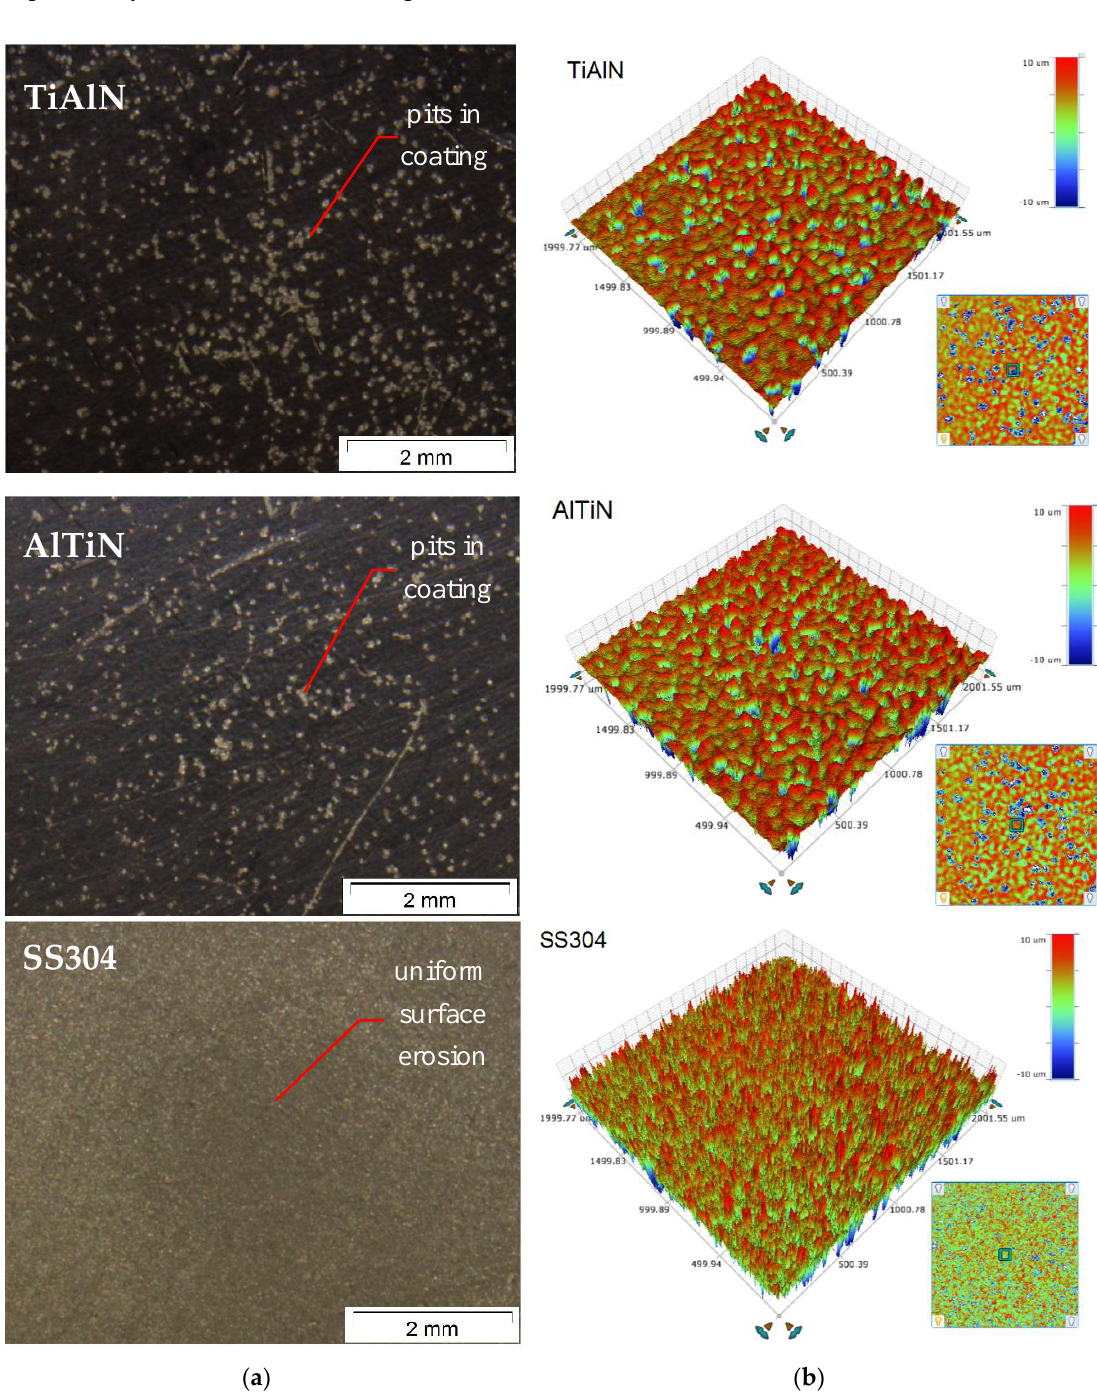
Figure 7. Macroscopic view of cavitation erosion-worn surface, stereoscopic microscope ( a ) and roughness profile of tested surfaces ( b ), after 4.5 h of cavitation testing.